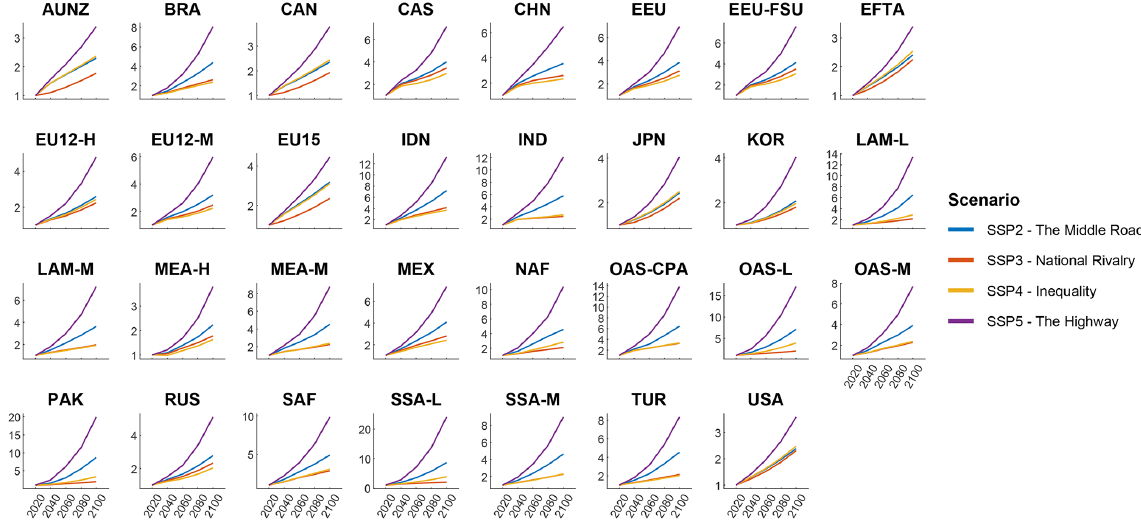
Figure 14. Regional F cap factor variation in the SSP IIASA database (R32). Source: https://tntcat.iiasa.ac.at/SspDb/ (last access: 14 October GDP 2022). The country mapping is provided in Table A5.